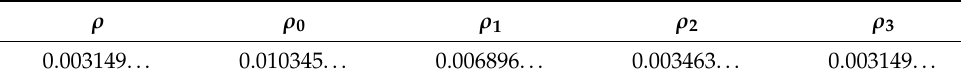
Table 4. Radius for Example 4.